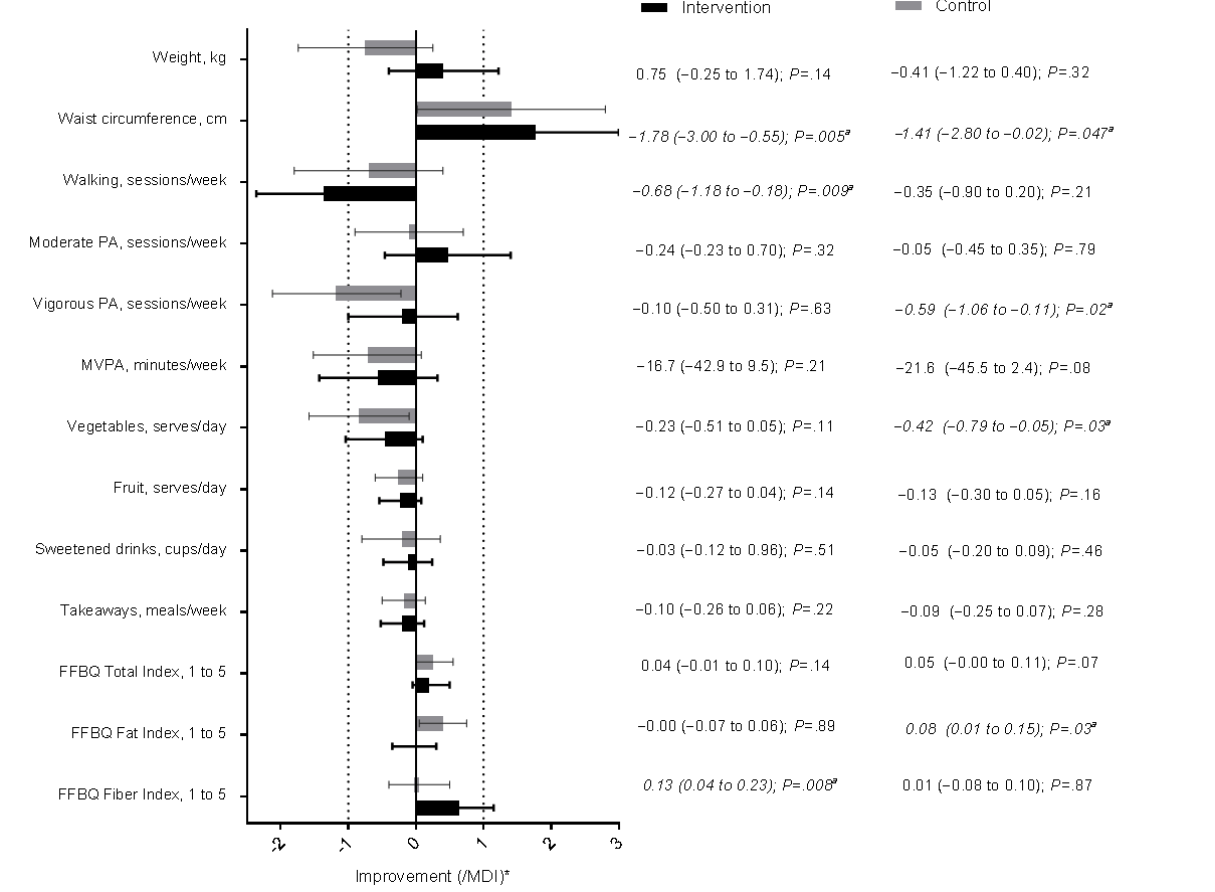
Figure 1. Mean changes (95% CI) between baseline and 12 months in study outcomes plotted as multiples of the minimum difference of interest (MDI) in the Get Healthy, Stay Healthy (GHSH) intervention (n=114) and control (n=114) groups ("a" indicates significant change P <.05. Asterisk indicates that the x-axis values for the means and CI are displayed as the mean, upper limit, and lower limit divided by the MDI value. Missing data are excluded for the intervention group or control group: n=13/3 [weight], n=14/6 [waist circumference], n=12/3 [self-reported physical activity and diet outcomes], and n=16/9 [accelerometer moderate-to-vigorous physical activity, MVPA]). FFBQ: Fat and Fiber Behavior Questionnaire; PA: physical